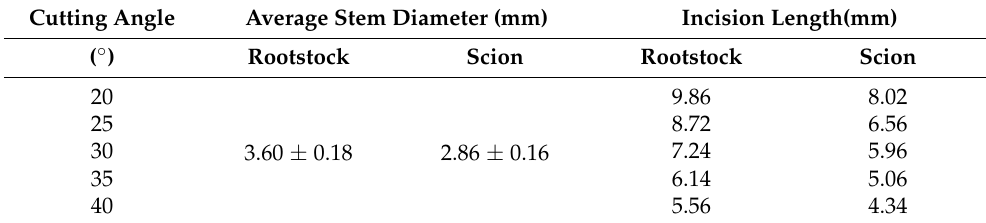
Table 1. Incision lengths of rootstocks and scions with different cutting